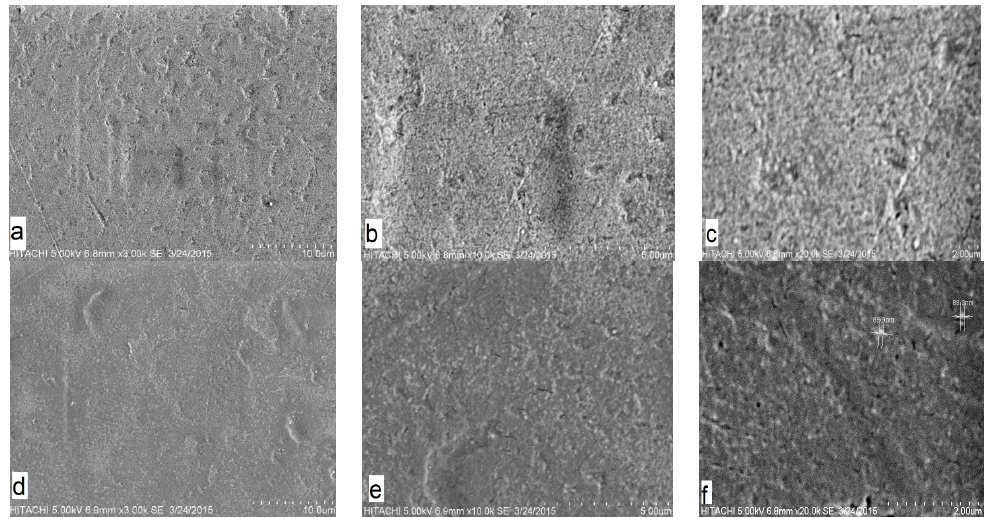
Figure 2. SEM images for PMMA and PMMA/10%CAB blend with different scale bars: ( a ) PMMA/10 µm; ( b ) PMMA/5 µm; ( c ) PMMA/2 µm; ( d ) PMMA/10%CAB/10 µm; ( e ) PMMA/10%CAB/5 µm and ( f ) PMMA/10%CAB/2 µm.